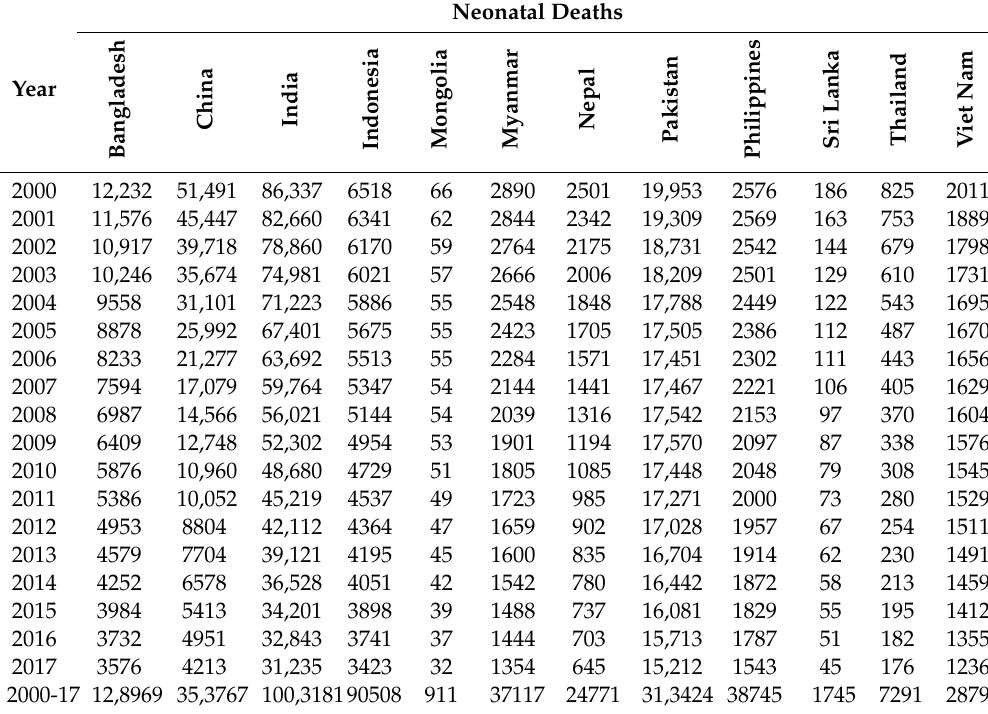
Table 1. Number of neonatal deaths due to acute respiratory infection over the study period between 2000 and